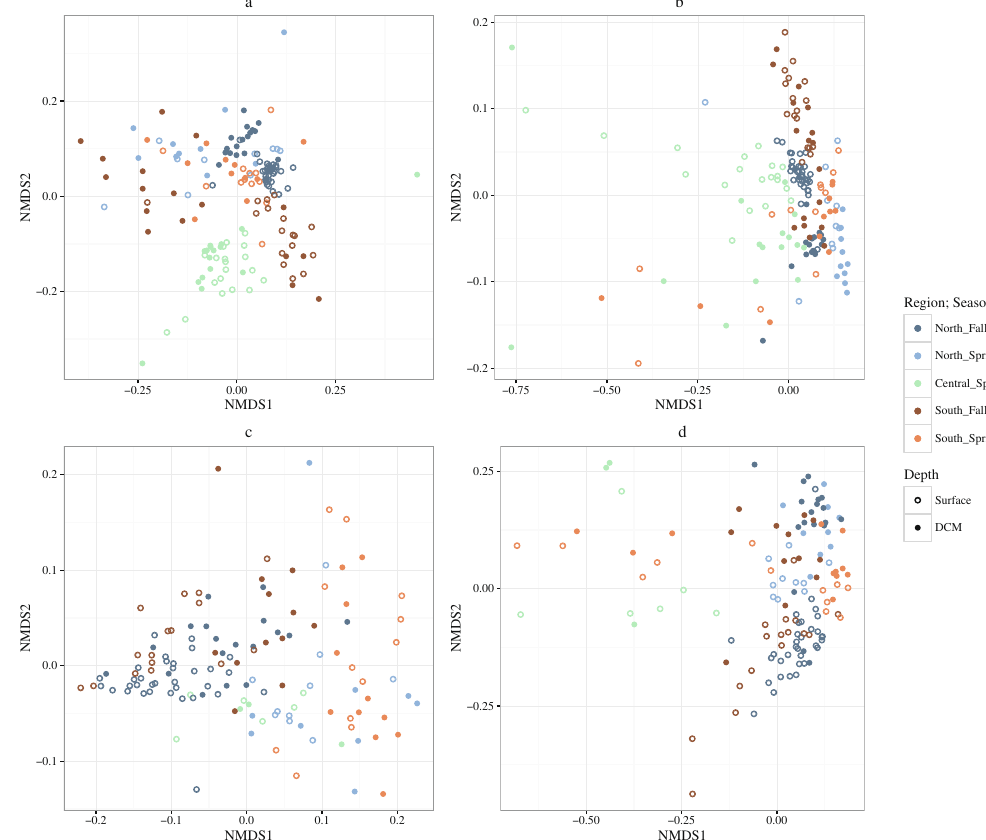
Figure 3. NMDS for eukaryotes – ( a ) weighted UniFrac ( b ) unweighted UniFrac and prokaryotes ( c ) weighted UniFrac and ( d ) unweighted